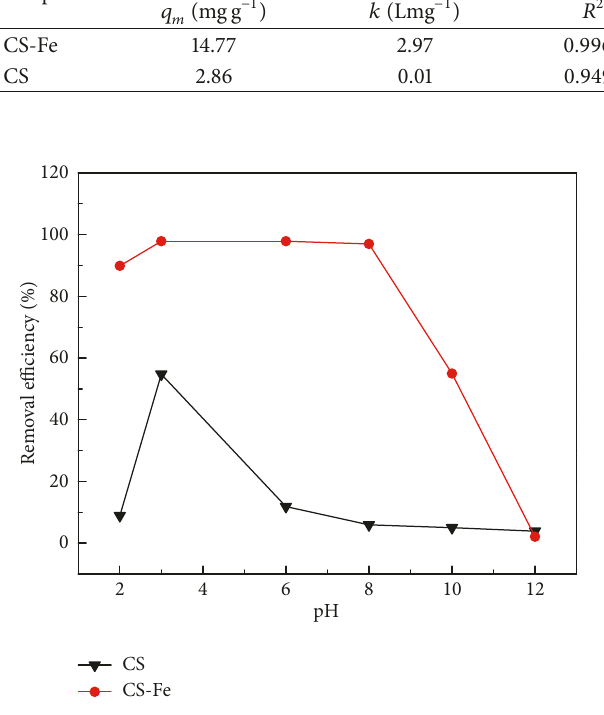
Figure 3: Adsorption isotherms of As(V) on CS-Fe and CS (adsor- bent dose 5 gL −1 ; pH 3.0; temperature 30 ∘